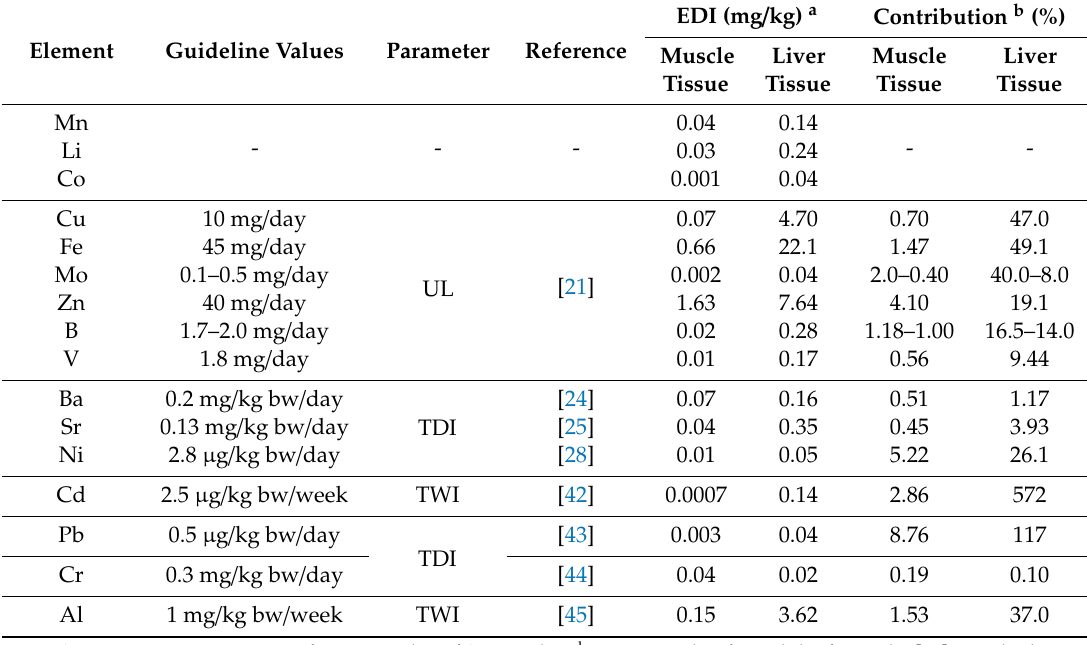
Table 6. Estimated daily intake values (EDI) (mg / day) and percentages of contribution to the dietary